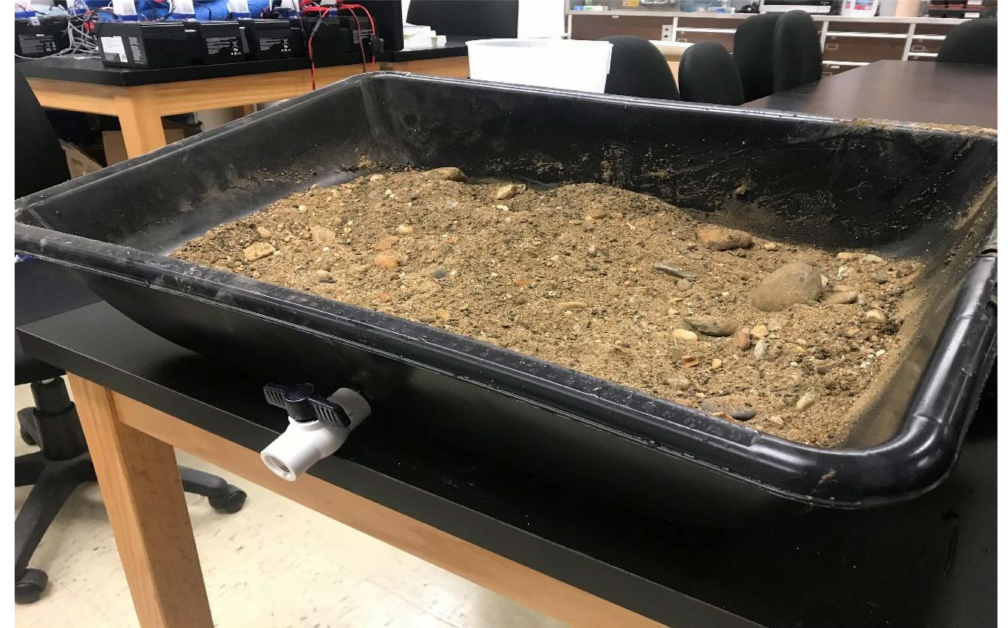
Figure 4. Sediment mesocosm tray set at 10 ◦ incline, filled with 6.5 L of hydraulic mine debris collected from the incised creek bed at Blue Point